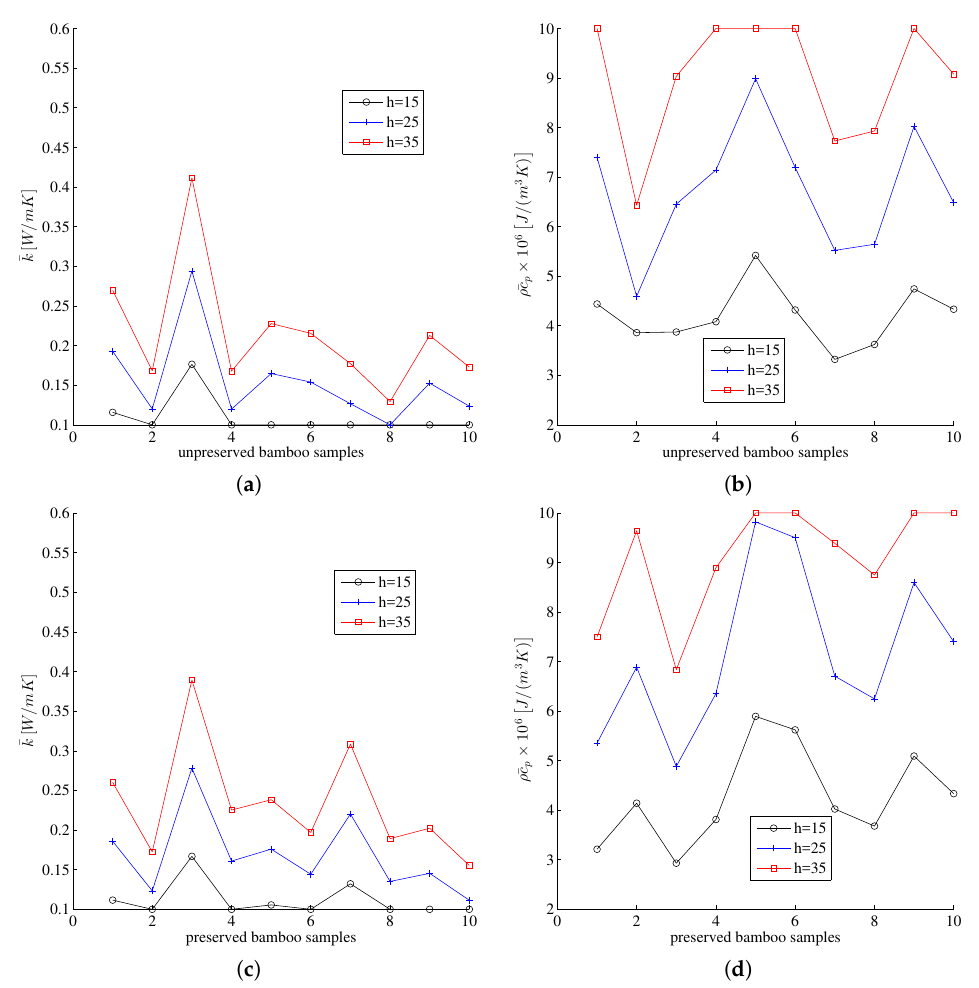
Figure 8. k and ρ c p estimates for unpreserved ( a ) and ( b ) and preserved ( c ) and ( d ) bamboo samples as the convective coefficient of air h varies.